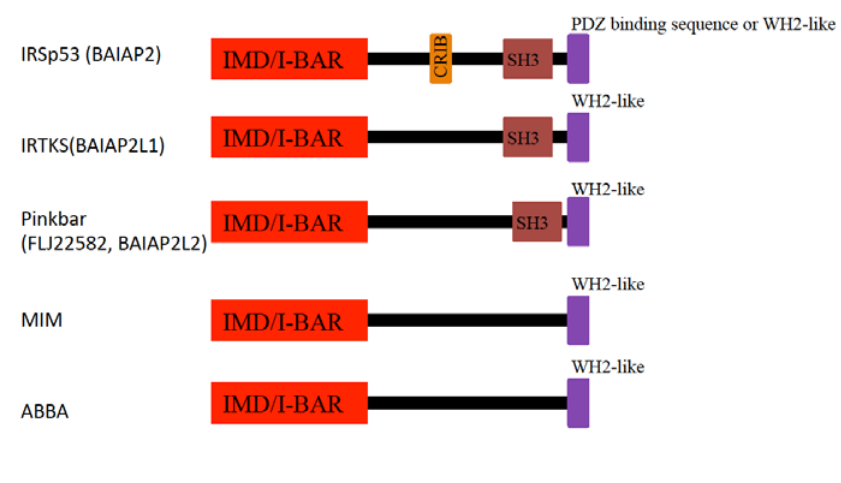
Figure 5. Schematic of domain organization of I-BAR proteins. IRSp53-MIM homology domain (IMD)/inverse-BAR (I-BAR); CRIB: Cdc42-Rac interactive binding region; SH3: Src homology 3 domain; WH2: Wasp homology 2 (verprolin homology)